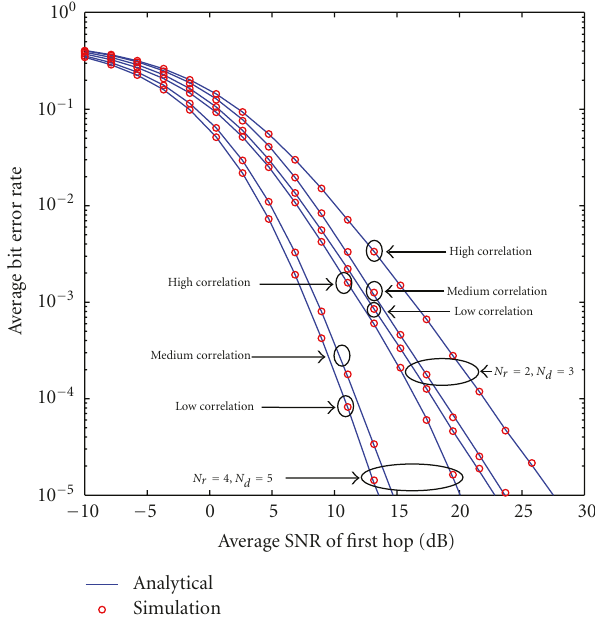
Figure 3: The impact of antenna correlation at the relay and destination on the average BER of BPSK. (a) High correlation: = π/ 48); (b) medium correlation: ( ρ , l d = 0 . 2, σ 2 ( ρ d h = π/ 24); (c) low correlation: ( ρ 0 . 5, σ 2 d = [0 . 8,0 . 85], ρ = [0 . 55,0 . 45], and ρ ρ h m = [0 . 8,0 . 85,0 . 75,0 . 8], and ρ and ρ h [0 . 2,0 . 3,0 . 25,0 . 35] for N r =